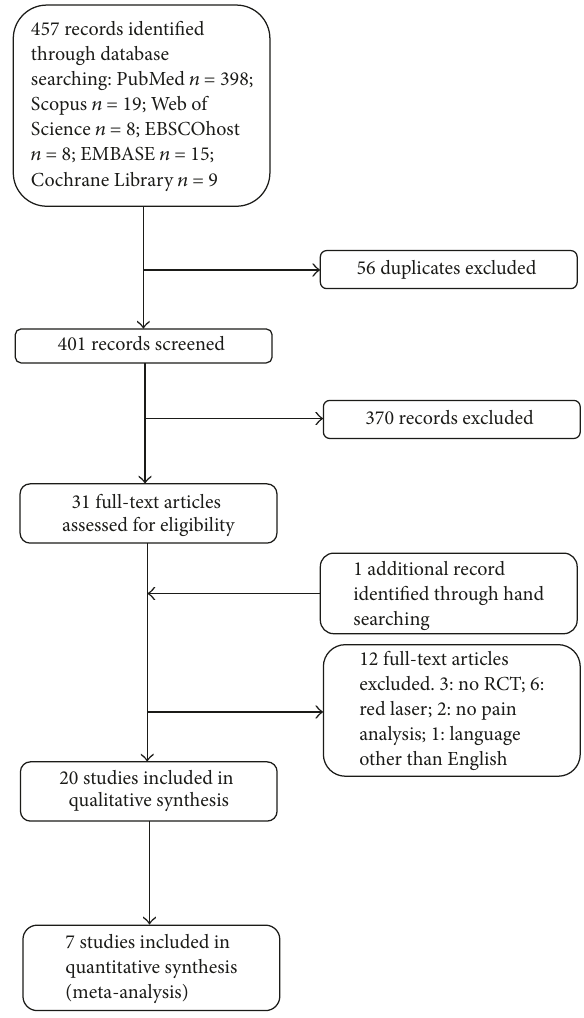
Figure 1: Flowchart of systematic literature